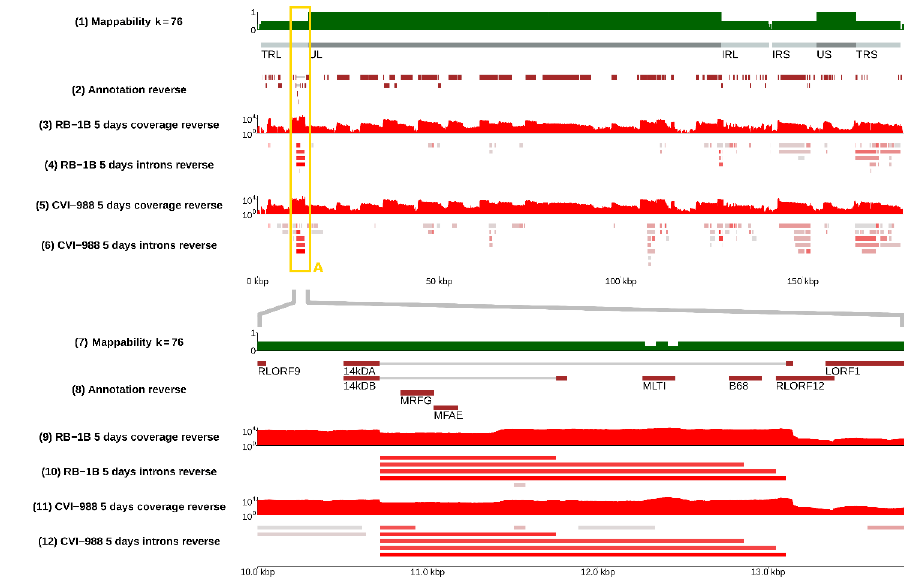
Figure 2. The splicing landscape at the junction between terminal repeat regions. Top panel : negative strand of the whole MDV genome; bottom panel : region from 10 to 14 kb (TRL/UL junction). The bottom panel is a magnified version of the content of the yellow frame A present in the top panel and in Figure 1. Alternative spliceforms across the 14KD polypeptide ( pp14 ) gene of MDV in strains RB-1B and CVI-988 are compared. From the RNA-sequencing signal, one can see four main alternative spliceforms in CEF cells infected by RB-1B, whereas five alternative spliceforms were identified in cells infected by CVI-988. As shown in track (8) (annotation), only two isoforms (14 kDA and 14 kDB) were present in the standard MDV annotations, as defined by Hong and Coussens [40]. The bottom panel of this figure can be reproduced in the online MDV genome browser by accessing https: // mallorn.pirbright.ac.uk / browsers / MDV-annotation / Figure-2.html.